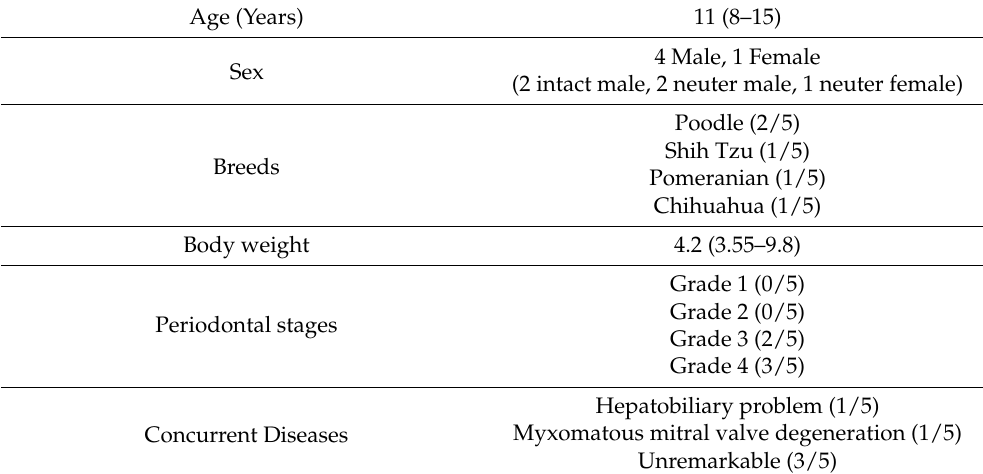
Table 1. Signalments including age, sex, breed, body weight, periodontal stages and concurrent diseases of five